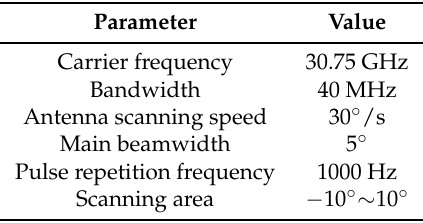
Table 3. The 2-D Simulation Parameters.